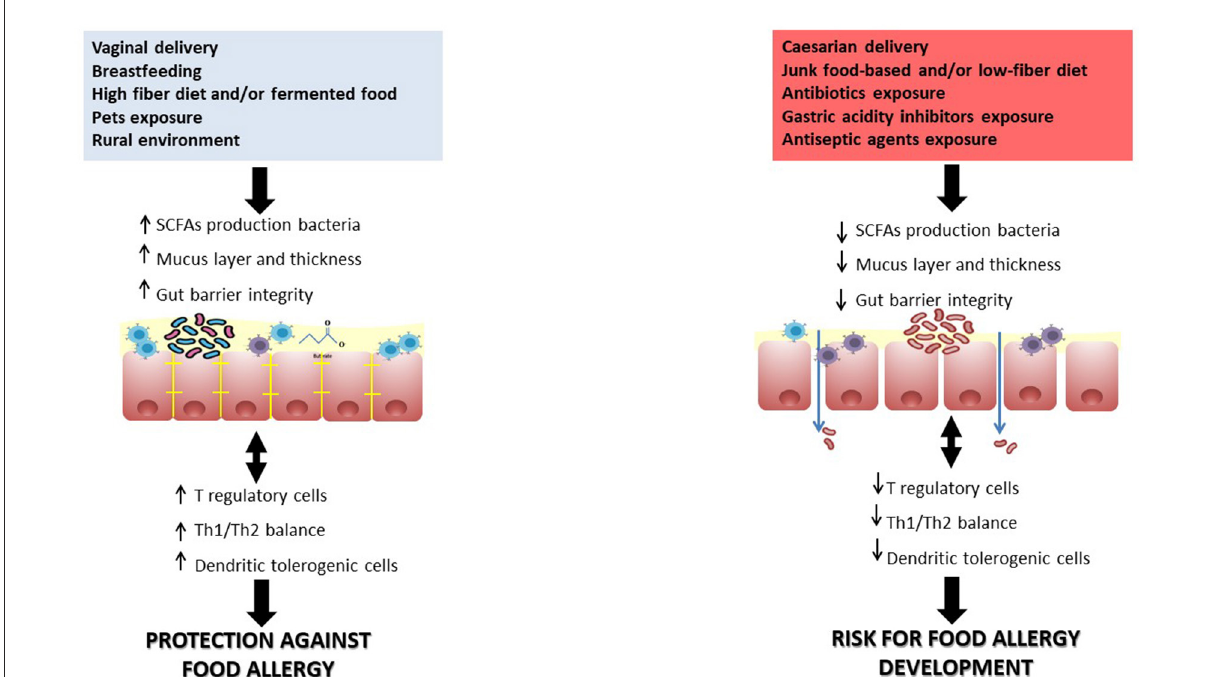
FIGURE1 The GM-immune system axis is responsible for pivotal regulation of long term health status, mainly through epigenetic mechanisms. For instance, healthy dietary and lifestyle habits such as Mediterranen diet (full of fibers, fermented foods, antioxidants, omega-3), breastfeeding, exposure to pets and/or rural environment, vaginal delivery, and use of probiotics are responsible for a positive influence on the axis. Conversely, cesarean section, prenatal, and early-life exposure to antibiotics/gastric acidity inhibitors/antiseptic agents, unhealthy diet (low fibers/high saturated fats and junk foods) influence negatively the axis. These environmental variables are becoming important targets for active prevention of